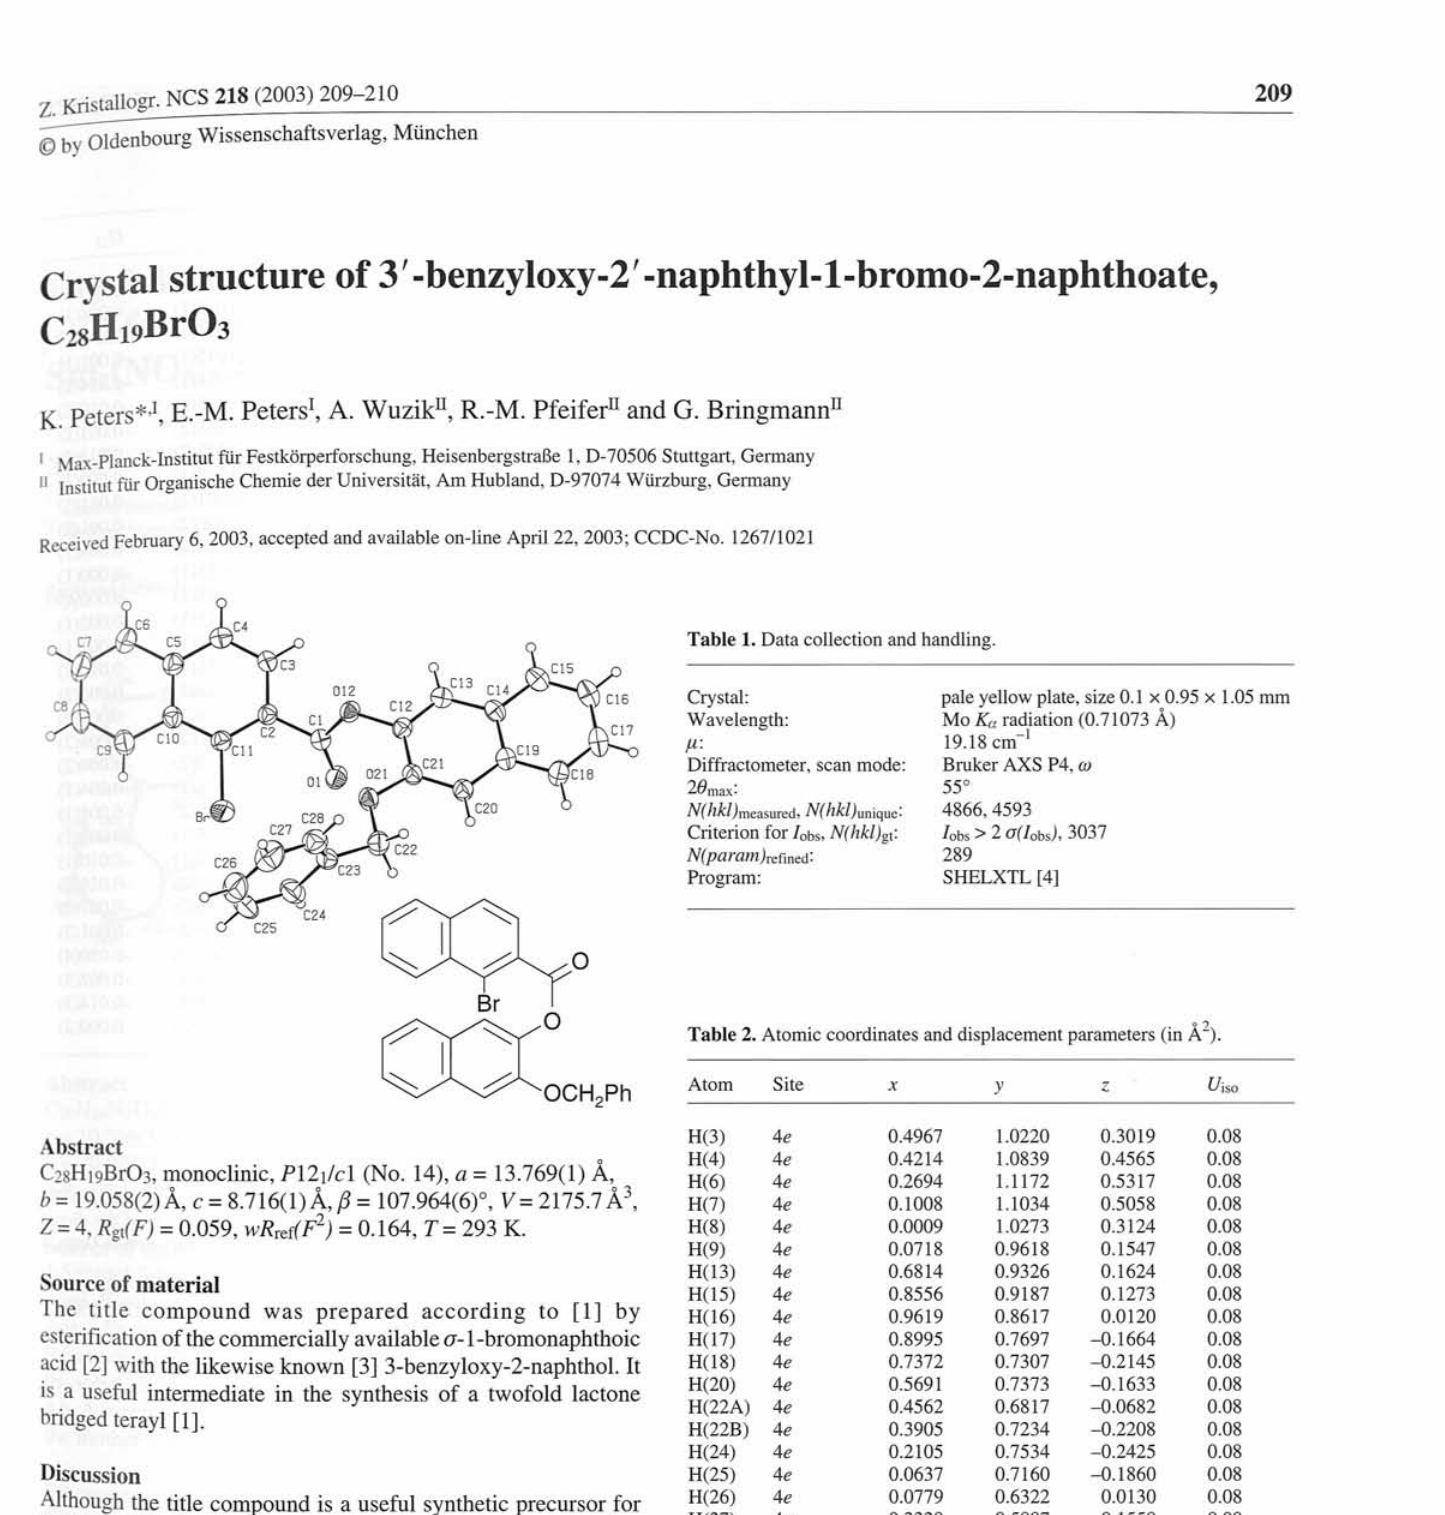
Table 1. Data collection and handling.